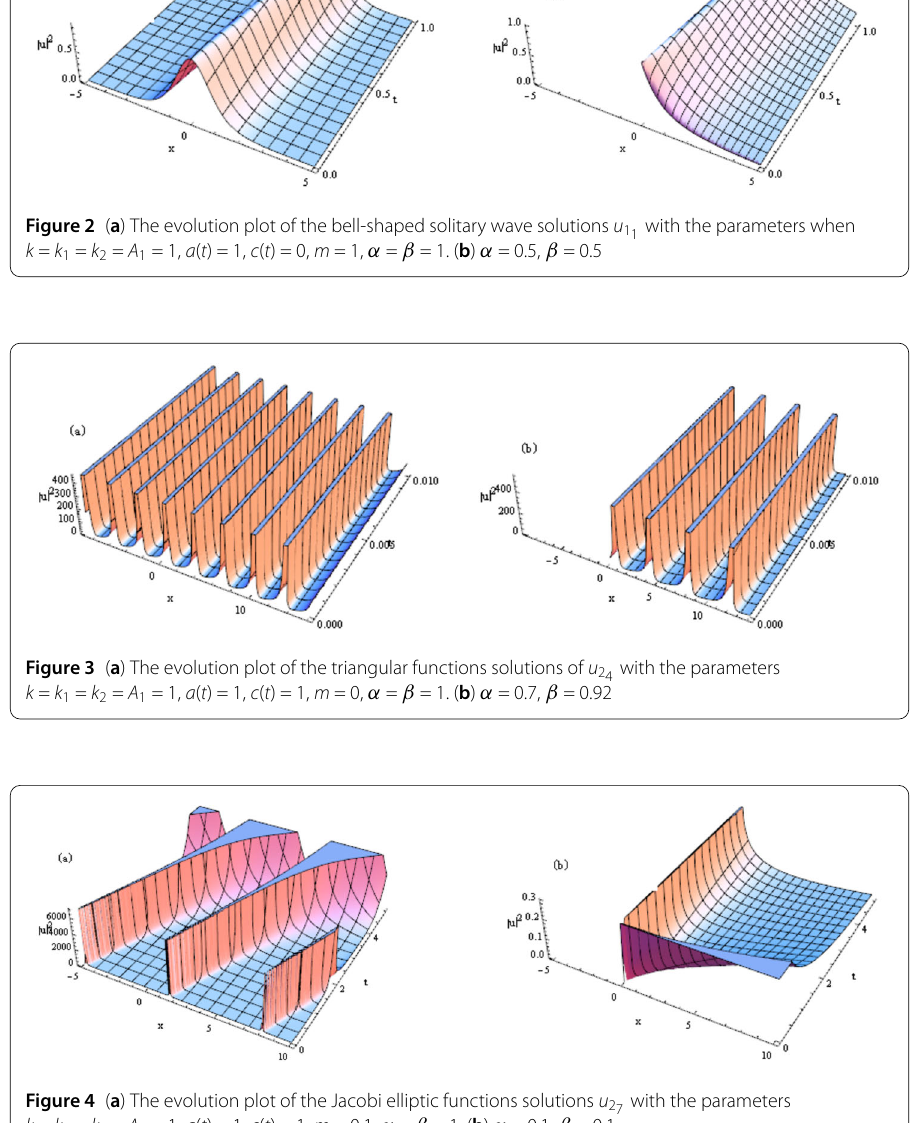
Here u 0 = u ( x ,0) = f ( x ), λ ( t , x ) is a general Lagrange multiplier, which can be identified op- timally with the variational theory. The function ˜ u n is a restricted variation, which means λ ( t , x ) that will be identi- δ ˜ u n = 0. Therefore, we first determine the Lagrange multiplier fied optimally via integration by parts. The successive approximations u n +1 , n ≥ 0, of the solution u ( x , t ) will be readily obtained upon using the obtained λ ( t , x ) and any selective function u 0 . The initial values are usually used for choosing the zeroth approximation u 0 . Consequently, the exact solution may be procured by using u = lim n →∞ u n . In the following, we will apply the MFVIM to a model about Eq. (2) to illustrate the strength of the